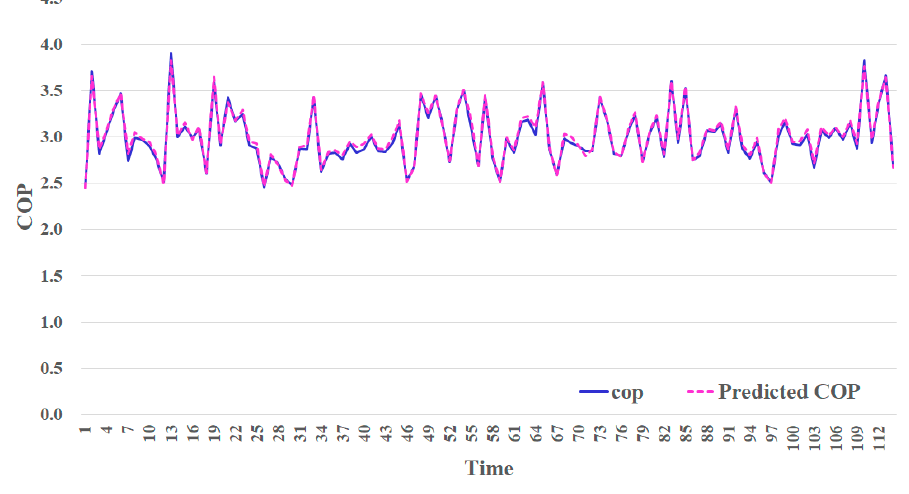
Figure 10. BAS application and monitoring result of predictive model.